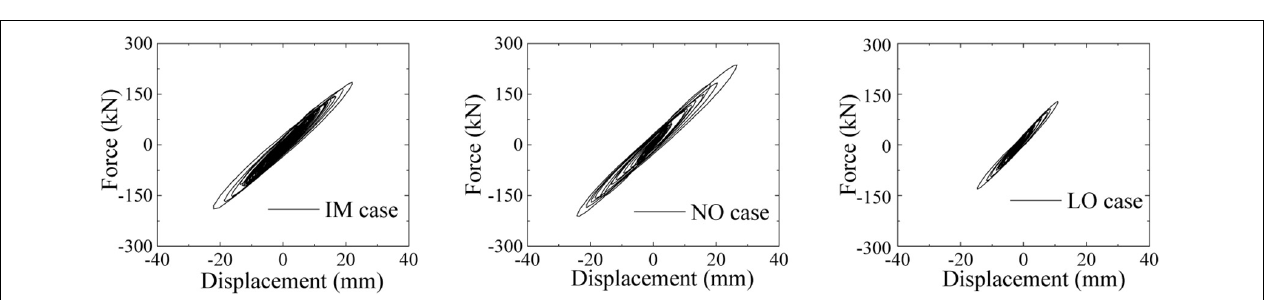
FIGURE 11 | Force-displacement hysteretic